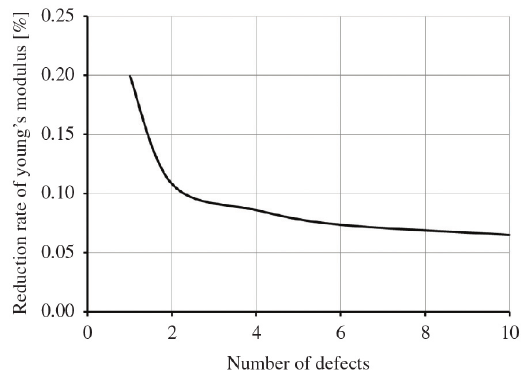
Figure 10. Trend of Young’s modulus reduction for (20, 20) CNT with S-W defects.